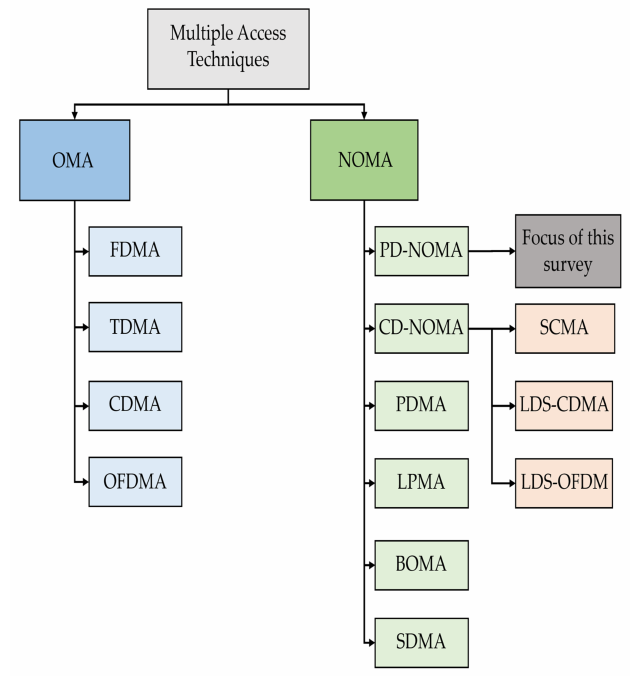
Figure 6. Classification of multiple access